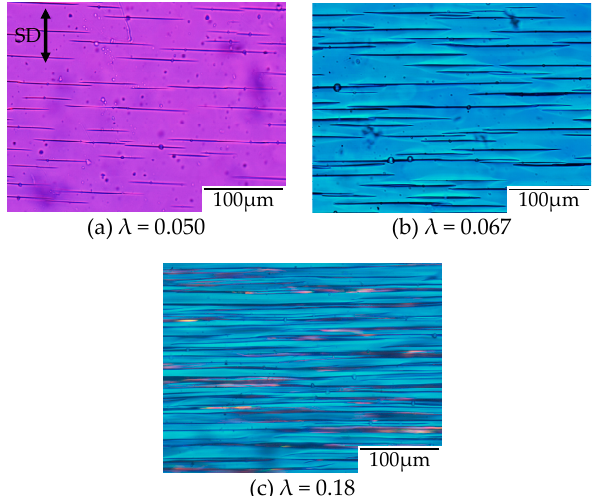
Figure 9. Polarized optical micrographs of OD-PC obtained by stretching under CO 2 at 5 MPa at various strains.